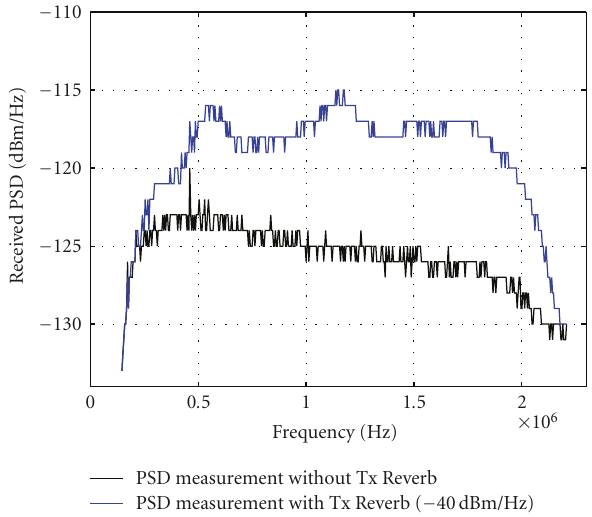
Figure 6: FEXT PSD measurements performed via loop diagnostic (LD) with and without transmitting the Reverb test signal on a neighboring